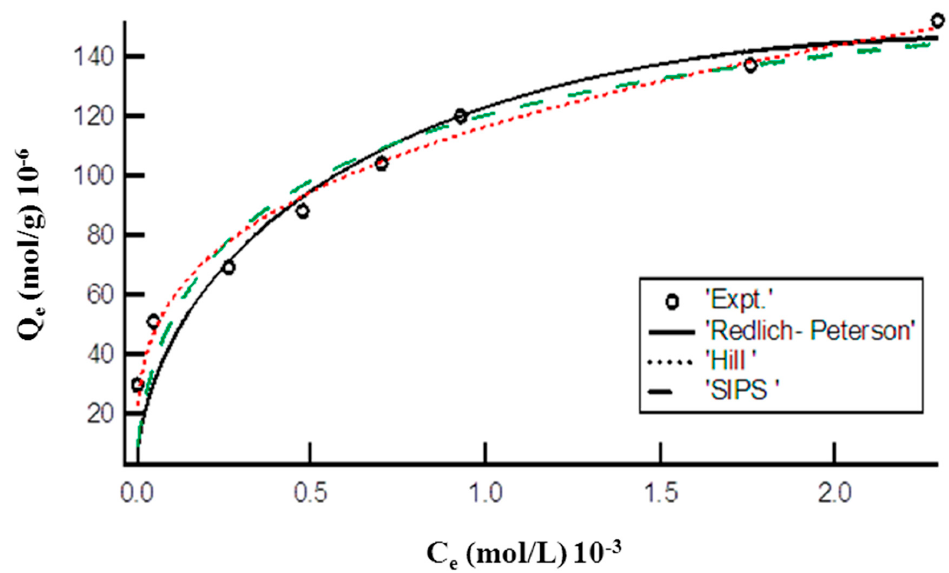
Figure 4. Plot of equilibrium concentration (C e ) vs. adsorption capacity (Q e ) representing nonlinear Hill, R-P, and SIPS isotherms for adsorption of MO onto the DMEA-grafted AEM.